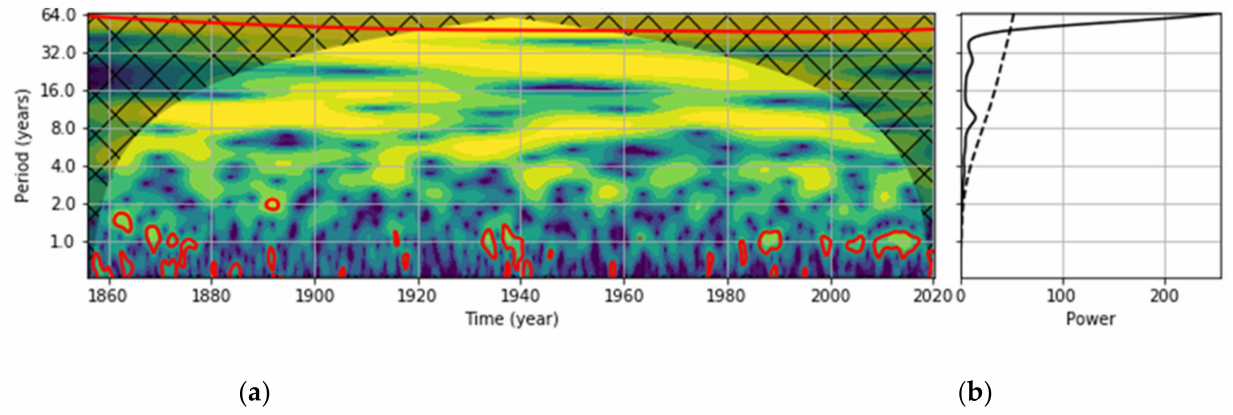
Figure 21. Results of wavelet analysis of the AMO index, illustrating the quasi-periodic behavior: ( a ) wavelet power spectrum and ( b ) global wavelet